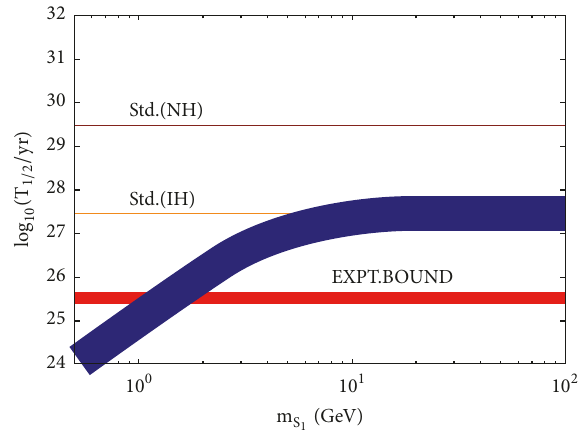
Figure 9: Same as Figure 8 but with contributions of IH type light neutrinos combined with lightest sterile neutrinos.